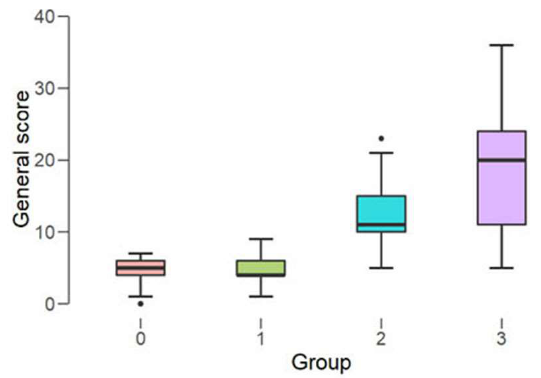
Figure 3. Periodontal disease and associated cardiovascular disease in association with the general OHIP-14 score (Group 0: no cardiovascular/no periodontal disease (N = 57); Group 1: cardiovascular disease only (N = 147); Group 2: periodontal disease only (N = 131); Group 3: periodontal and cardiovascular disease (N = 114)). The dots in group 0 and group 2 represent extreme values of OHIP-14 general score: 0 and 23, respectively.